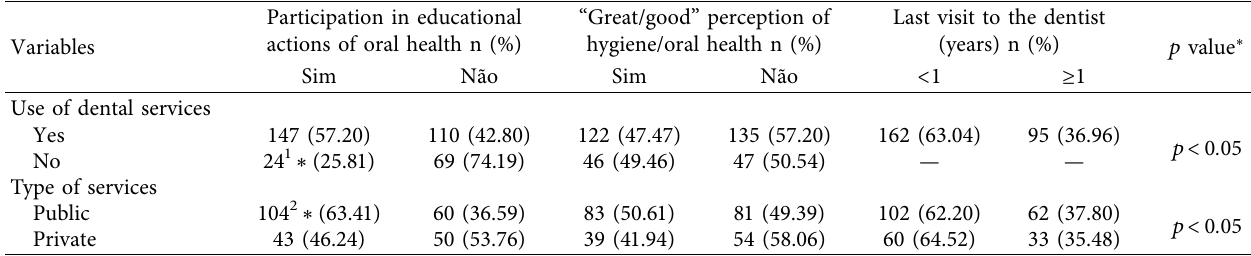
Table 3: Association between types, time and use of dental services, participation in educational activities, and self-perception of health and oral health by Brazilian and international academics. Redenção e Acarape, CE, Brazil,